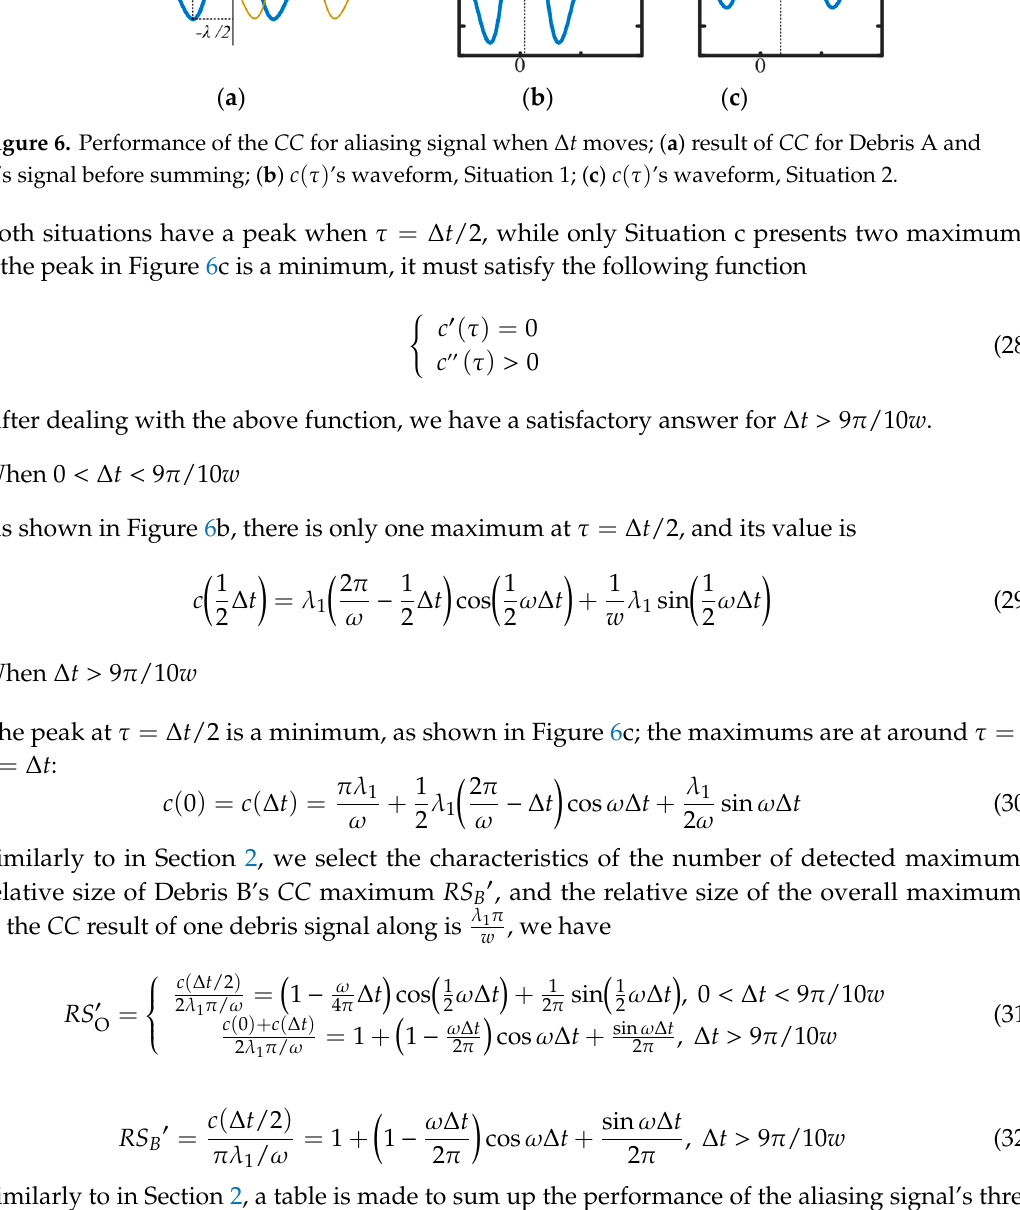
Table 2. P er formance of two similar debris particles’ aliasing after CC .